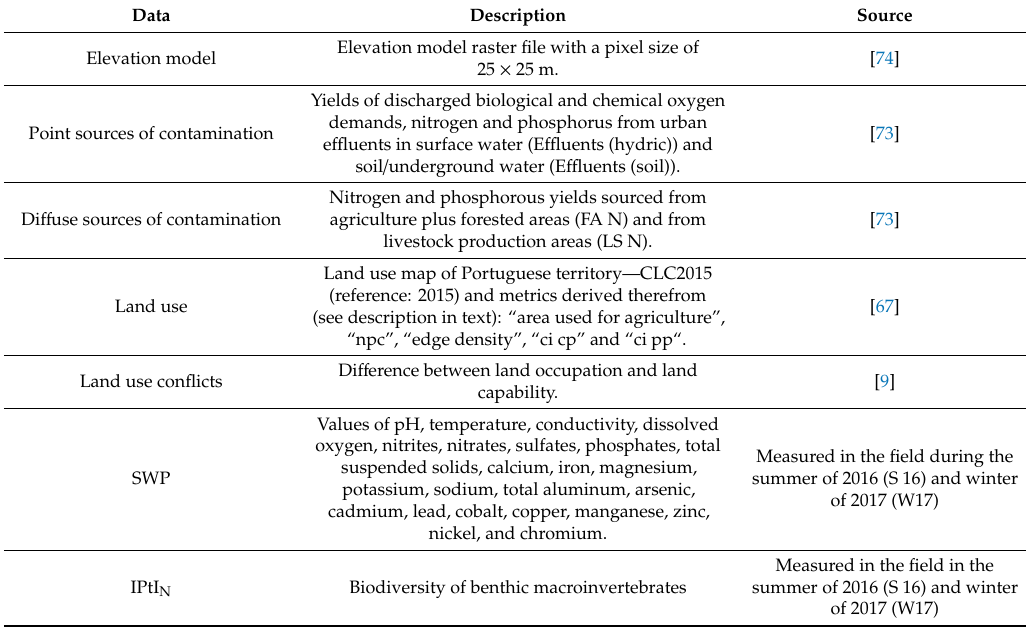
Table 1. Sources of information used in the PLS-PM (PLS-Path Modeling)